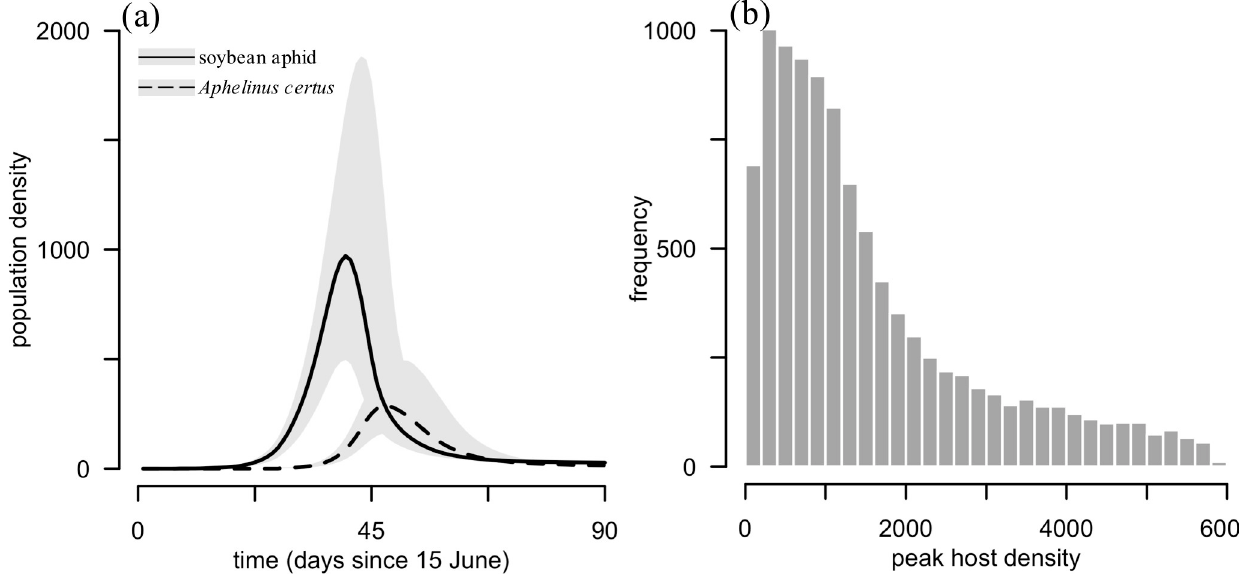
Fig 3. Population dynamics predicted by the matrix model. (a) Population dynamics of soybean aphid and A . certus . Black lines represent median densities with the interquartile (Q1–Q3) range shaded in gray. Solid line: soybean aphid (all living aphids); Dashed line: Aphelinus certus (all stages). Dotted horizontal line: economic threshold. (b) Histogram of peak aphid densities simulated from the